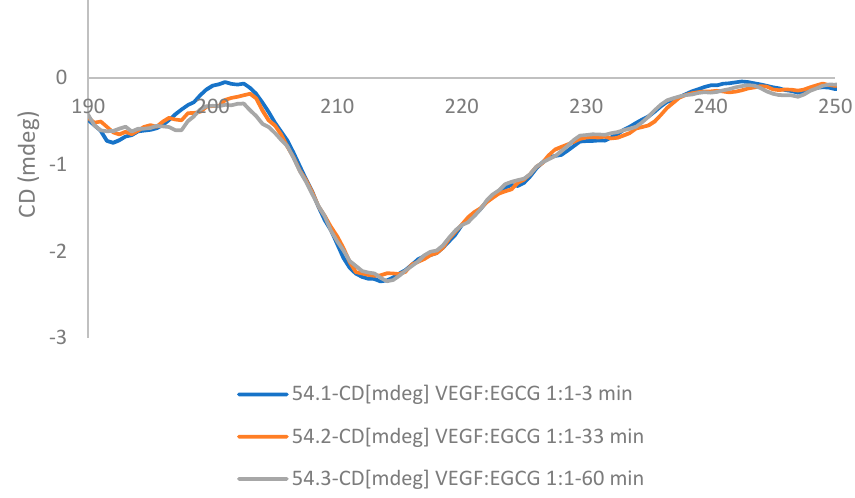
Figure 5. CD spectra of VEGF:EGCG 1:1 after mixing at 3 min (blue line), 30 min (orange line) and 60 min (grey line).